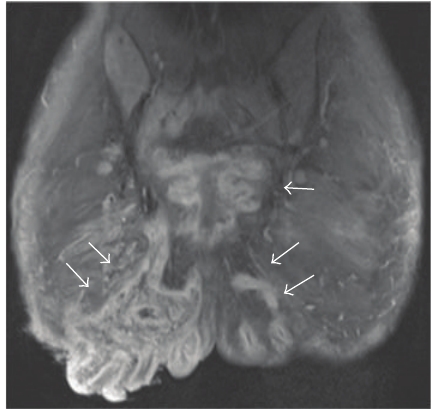
Figure 1: Axial FSE T2-weighted fat-suppressed image at pre- sentation shows complex right gluteal subcutaneous collections with heterogeneous high T2-weighted signal intensity and low T1- weightedsignalintensity(notshown).Thetubularcollections(white arrows) are reminiscent of branching primary and secondary sinus tracts and probably represent the chronic phase of these suppurative inflammatory tracts, extending to the deep right ischiorectal and ischioanal spaces. Bilateral dermal thickening and induration are seen. Bilateral enlarged inguinal lymph nodes are also demonstrated ( ∗ ).